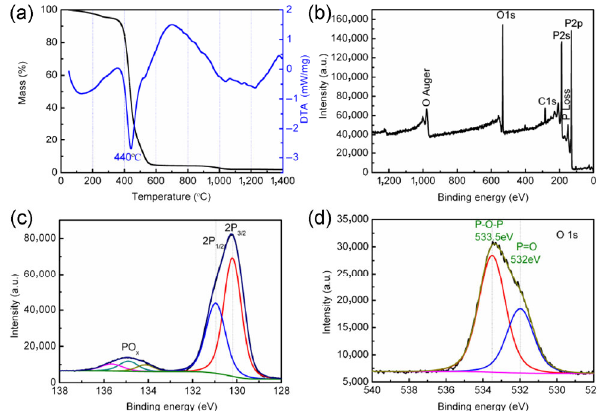
Fig. 5 DTA (a) and XPS (b − d) survey spectrum of black phos- phorus powder at BM for 30